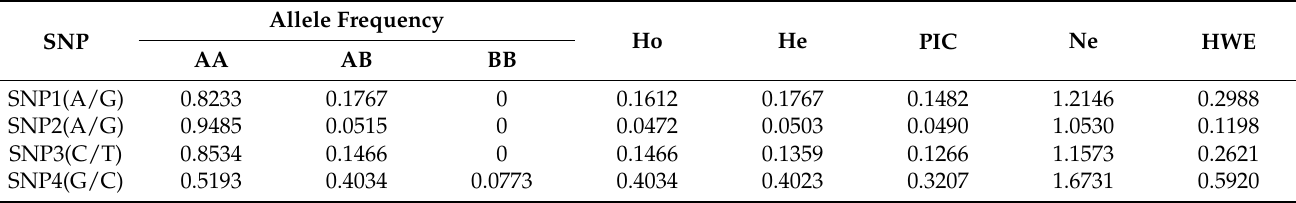
Figure 4. The sequencing peak map of the SSTR1 and the mutated SNP4 site of Hulun Buir sheep. The sites marked by the red arrow was the SNP4 mutation, which was found and identified in exon Table 2. Population genetics analyses of SSTR1 of in Hulun Buir sheep 1 . 2 of SSTR1 , G951C (rs405457403). The sequences were analyzed using DNAMAN software.